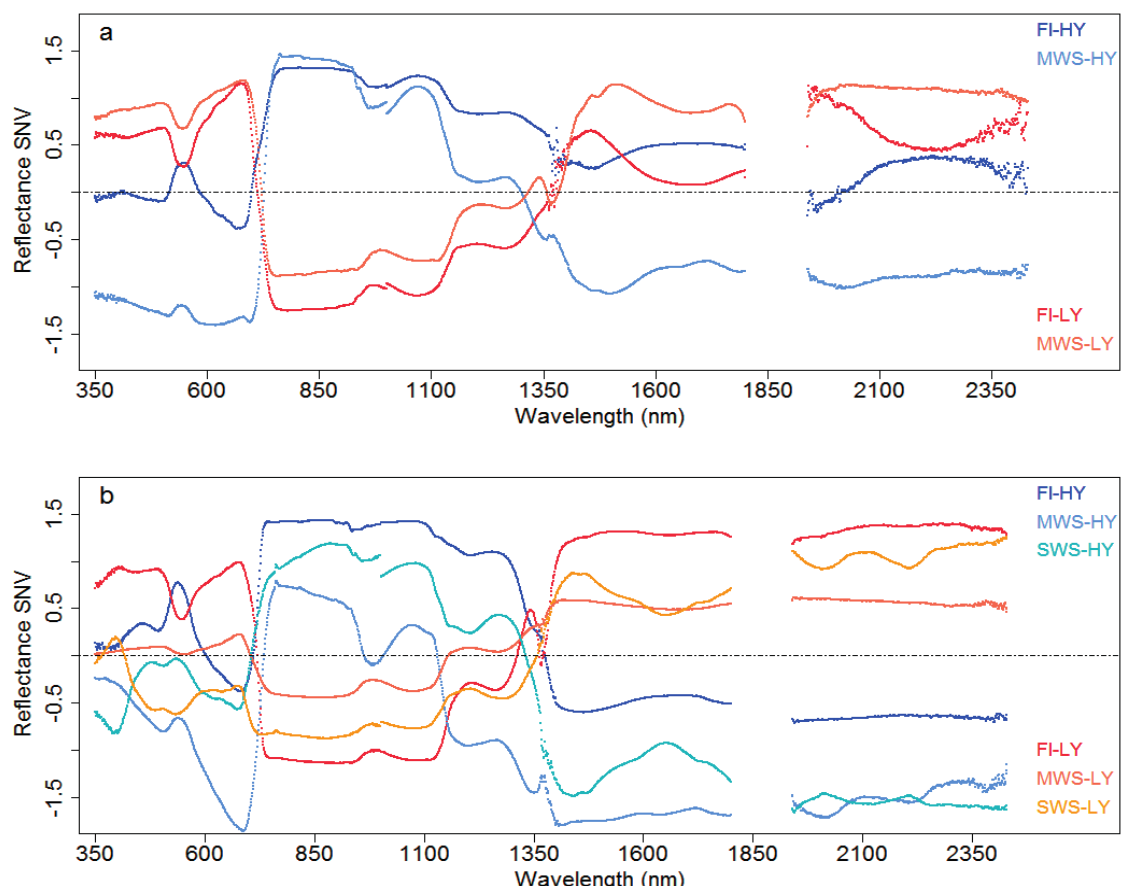
Figure 2. Standard normal variation (SNV) reflectance of 15 genotypes with the highest (HY) and lowest (LY) yields determined at the anthesis ( a ) and grain filling ( b ) stages, under severe water stress (SWS), medium water stress (MWS) and full irrigation